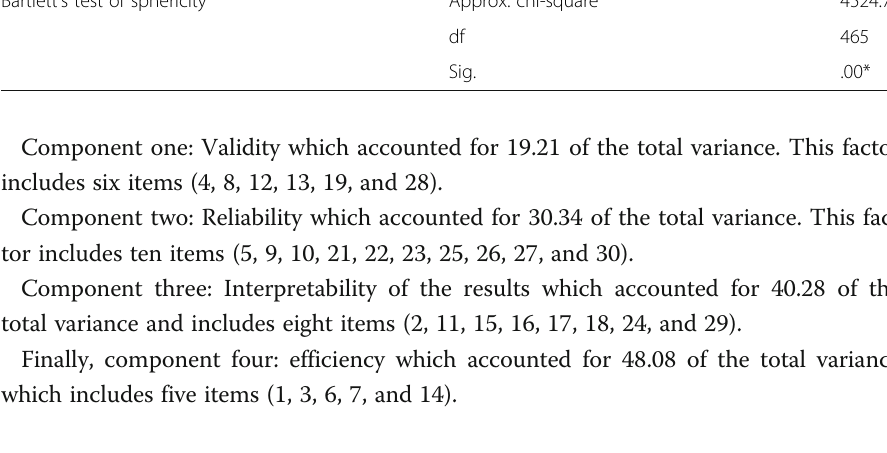
Table 3 KMO and Bartlett ’ s Test Kaiser-Meyer-Olkin measure of sampling adequacy .56 Bartlett ’ s test of sphericity